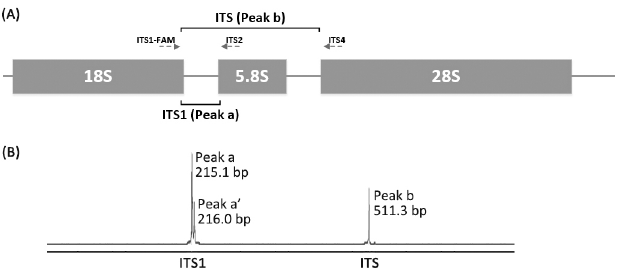
Fig 1. Principles for SCGE ITS length types (LTs) identification of yeast species. Fig 1A, structure of yeast ITS region and primers used in this study (showed in arrows with dashed lines). The duplex PCR using primers ITS1-FAM, ITS2 and ITS4 will theoretically generate two amplicons (for ITS1 and full-length ITS region, respectively). As the forward primer ITS1 was 5 ’ -end FAM labeled, the amplicons can be observed by SCGE examination (peaks “ a ” and “ b ” in Fig 1B). B. an example of interpreting the SCGE results (strain 12HX414). Peaks “ a ” and “ b ” represent amplicons of ITS1 and full-length ITS region, respectively. As peak “ a ” and “ a ’” were separated by less than 1 bp, only peak “ a ” was counted (see Methods section).